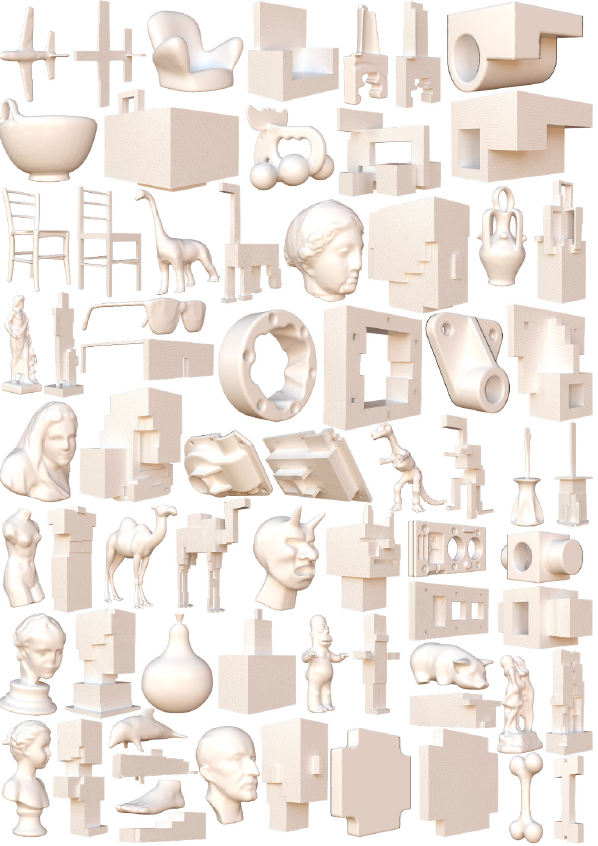
Fig. 15 Gallery of our polycube